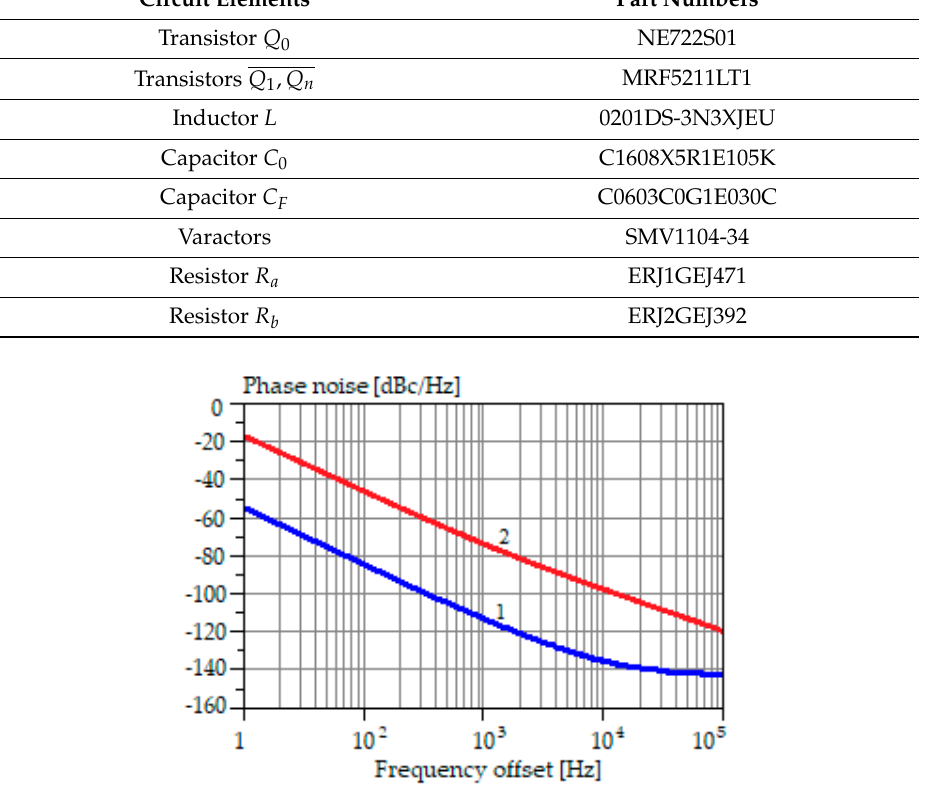
Figure 15. Phase noise versus offset frequency when C 0 = 1 µ F (curve 1) and C 0 = 1 nF (curve 2).